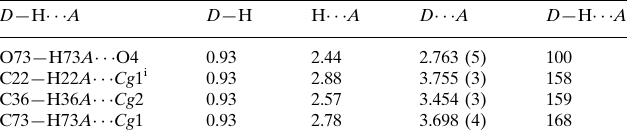
Hydrogen-bond geometry (A˚ , (cid:2)